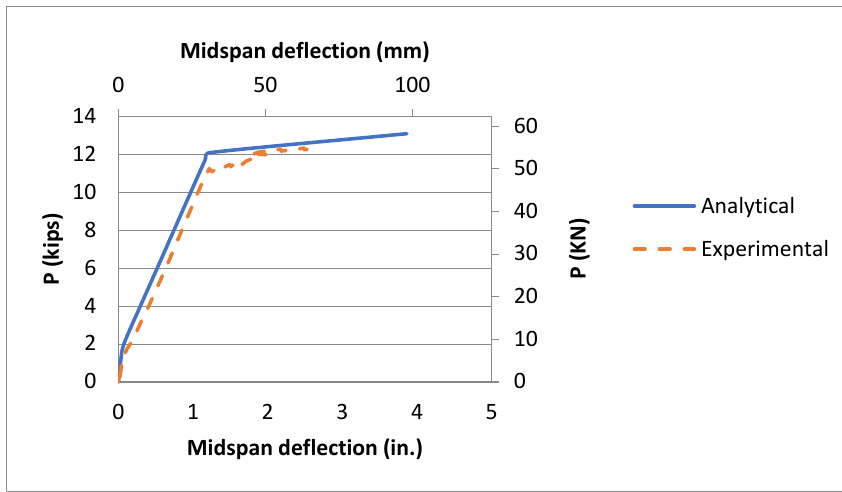
Figure 18. Decker (2007) [18] load vs. midspan deflection comparisons.